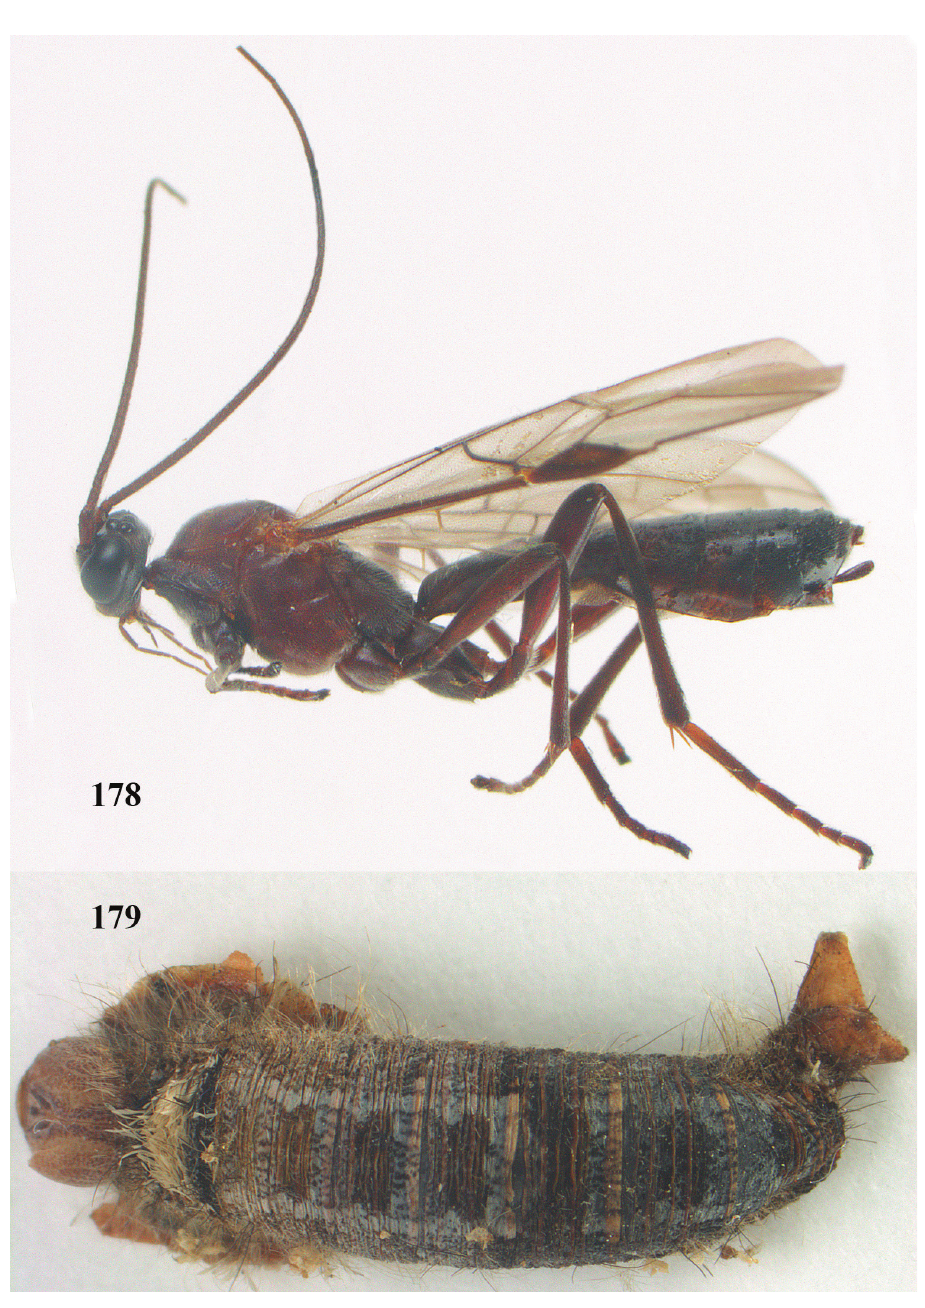
Figures 178–179. Aleiodes esenbeckii (Hartig) f. dendrolimi (Matsumura), ♀ , Russia, Sakhalin. 178 habitus lateral 179 mummy of Dendrolimus spectabilis (Butler) from